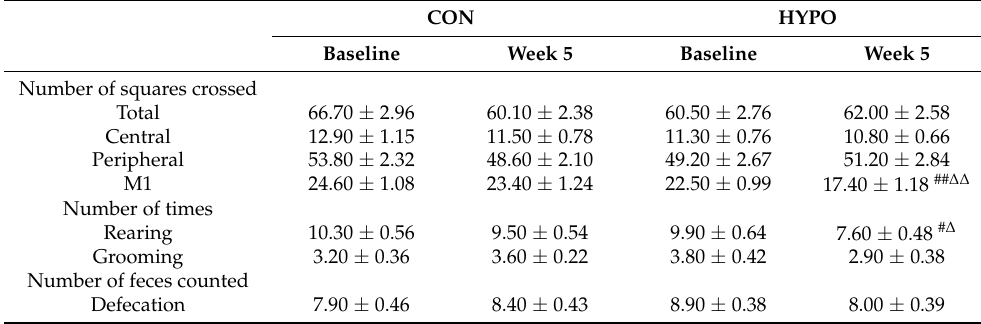
Table 1. Open field test results in CON rats and HYPO rats at baseline and week 5. CON HYPO